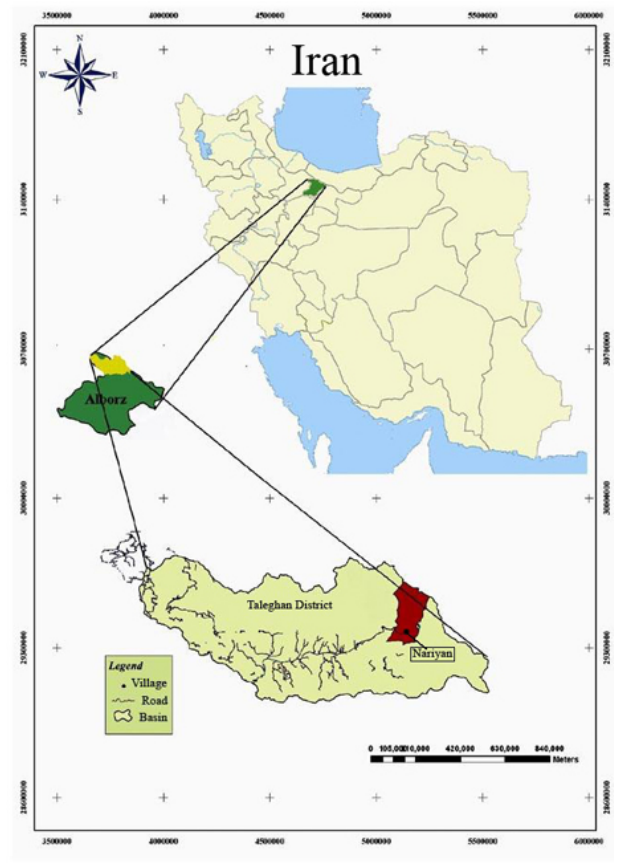
Fig. 1 . Map showing the location of Nariyan village in the province of Alborz in the Taleghan District in northern Iran. The traditional boundary of Nariyan village is shown in